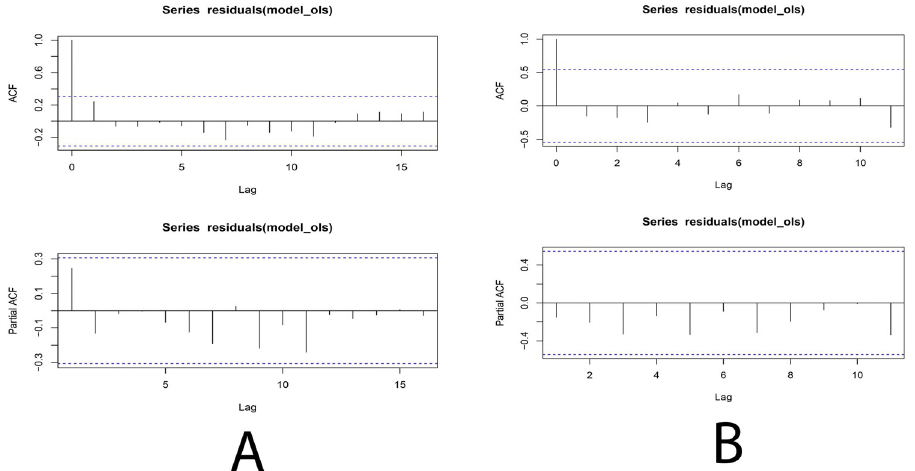
Fig 3. Autocorrelation and partial autocorrelation